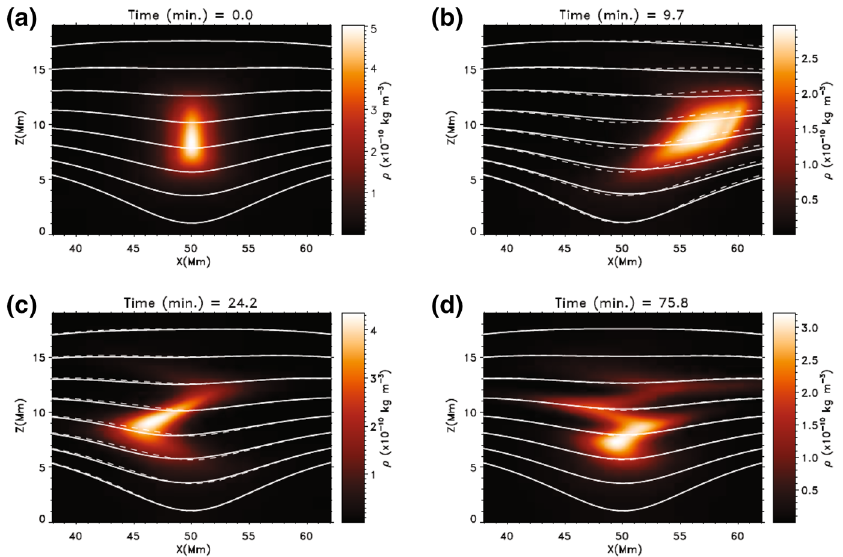
Fig. 6 Time evolution of prominence mass (in colours) and magnetic structure (white lines): a for t = 0; b maximum displacement of prominence mass attained; c phase difference between different parts of prominence mass; d zig–zag motion of the prominence mass. Time of each frame is shown at its top. Cartoon showing the wave-prominence and wave-filament interaction processes triggering transverse and longitudinal oscillations, respectively. Image reproduced with permission from Luna et al. (2016b), copyright by